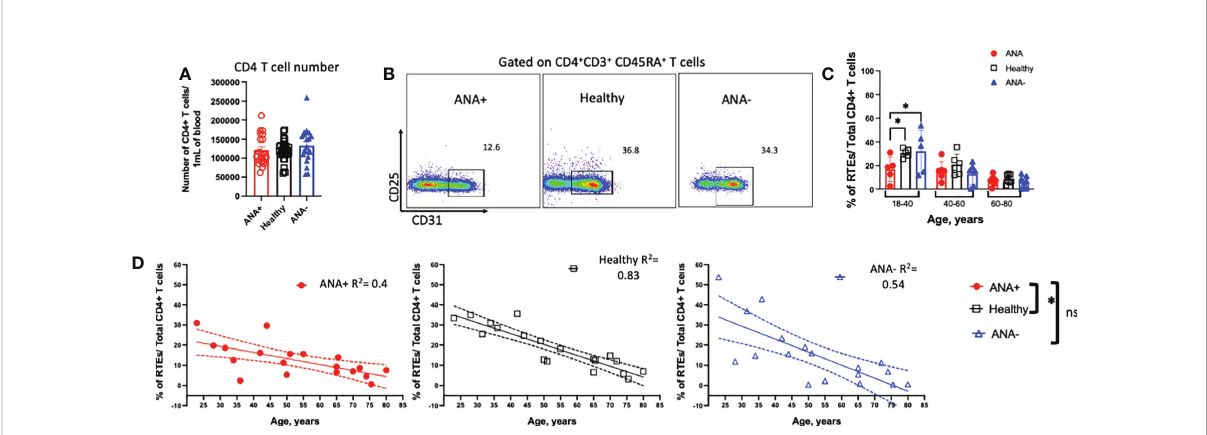
FIGURE 1 Young ANA-positive patients have fewer RTEs. PBMCs were isolated from whole blood and stained with antibodies to identify recenty thymic emigrants (RTEs). (A) The absolute number of CD4+ T cells per 1mL of blood was determined. (B) Representative fl ow plots of CD4+CD3+CD45RA+CD45RO- CD31+CD25- RTEs in ANA-positive patients, healthy blood donors, and ANA-negative patients. Subjects were analyzed in groups based on age ranges: 18-40 (young), 40-60 (middle), and 60-80 (old) years old. (C) The frequency of RTEs of total CD4+ T cells was calculated and data are shown as mean ± SEM and analyzed by a one-way ANOVA test followed by Tukey ’ s multiple comparison test; *p<0.05. (D) The correlation between the frequency of RTEs and age was plotted. Linear regression analysis was used for all three groups and R2 are reported. Each data point re fl ects one subject (ANA- positive = 20, ANA-negative = 20, healthy blood donors = 32). Subjects were analysed using multiple regression analysis incorporating age as a continuous variable and type of blood donors (ANA-positive, ANA-negative, healthy blood donors) as a categorical variable followed by Tukey ’ s multiple comparison test; *p<0.05; ns, non signi fi